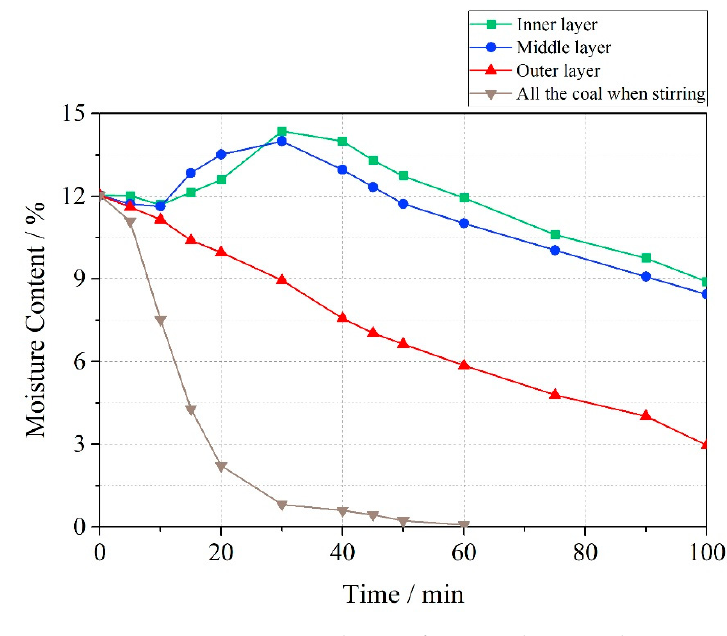
Figure 8. Moisture content change of static and stirring drying.